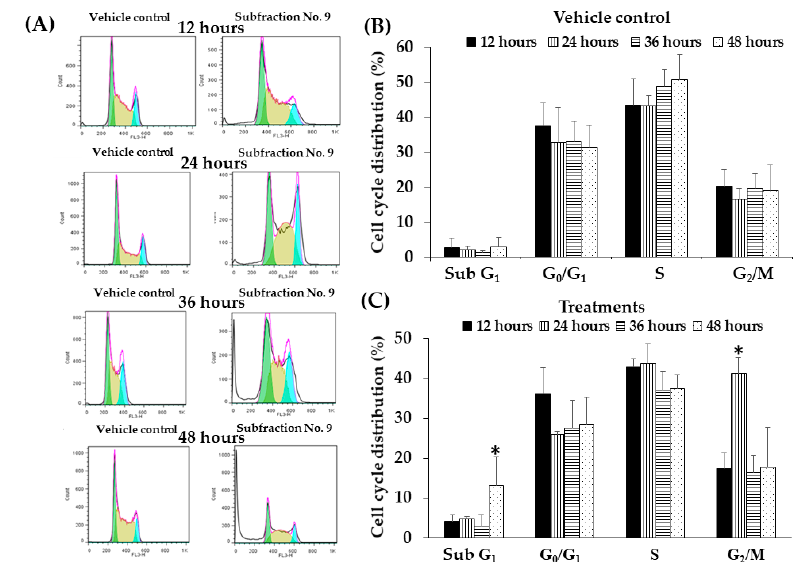
Figure 5. Cell cycle arrested after treated with Subfraction No. 9 (F9) for 12, 24, 36, and 48 h. ( A ) K562 cells at a density of 1.0 × 10 5 cells/mL treated with 10.0 µg/mL of F9 for 12, 24, 36, and 48 h. Cell cycle was analyzed by flow cytometry after fixation in 75% ethanol and stained with PI. ( B ) and ( C ) Cell cycle distribution after F9 treatments. Data are expressed as mean ± SD of three independent experiments. Asterisk (*) demonstrates statistically significant difference ( p < 0.05).